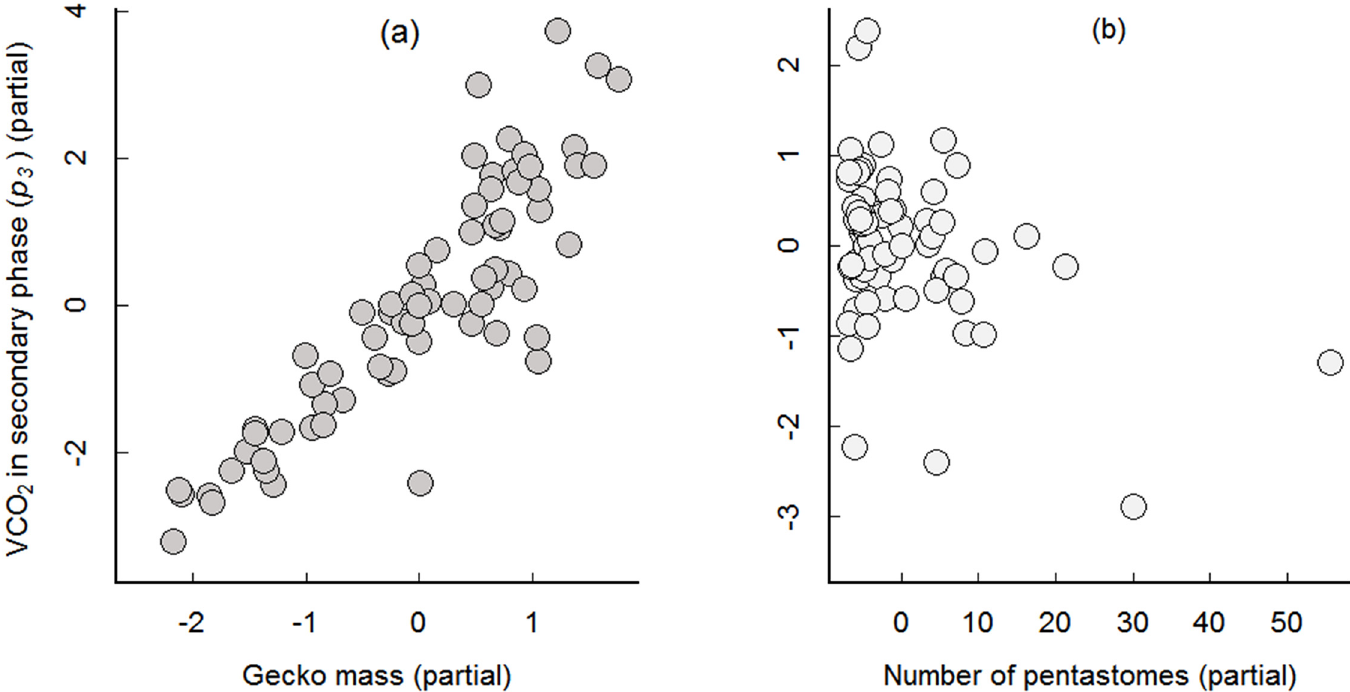
Fig 3. Relationship between mass and number of pentastomes versus VCO 2 production in secondary phase ( p 3 ) for recently active geckos. Partial regression plots ( y axis: residuals of regressing the response variable on the explanatory variables, but omitting the explanatory variable of interest, and x axis: residuals of each explanatory variable of interest regressed on all remaining explanatory variables) of (a) the relationship of gecko mass to VCO 2 produced in secondary phase ( p 3 ) for recently active geckos ( n = 70) given the effect of number of pentastomes and mites, and (b) the relationship of number of pentastomes to CO 2 produced given the effect of gecko mass (g) and mites. Minimal regression model for recently active geckos: VCO 2 ( p 3 ) = (1.411 × gecko mass) – (0.033 × number of pentastomes) – (0.063 × number of mites) + 0.141; model adjusted R 2 = 0.7649.